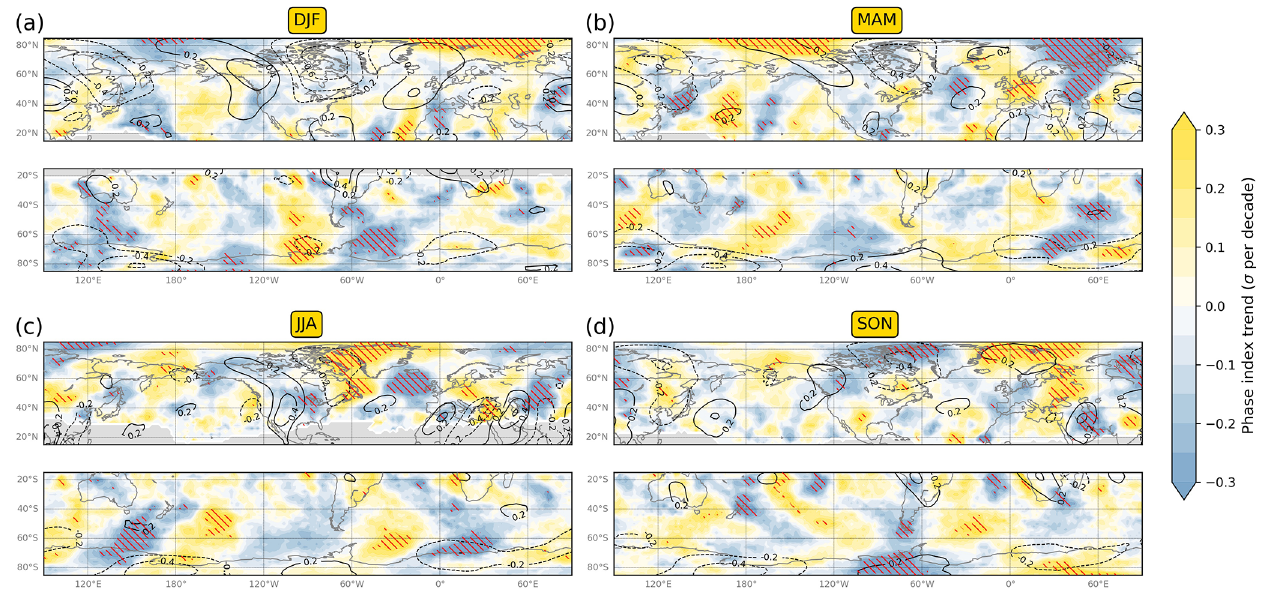
Figure 7. Same as Fig. 6, but for the phase index of RWP objects at 300hPa. Positive (negative) trends denote that the occurrence frequency of ridges increases (decreases) relative to that of troughs. The black contours correspond to the multiyear mean phase index based on the filtered v at 300hPa (solid and dashed contours denote positive and negative values, respectively). Masked grid points are indicated by grey